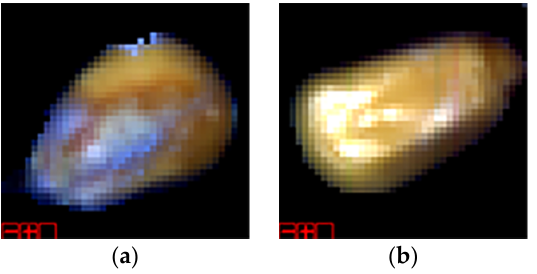
Figure 5. Pseudo ‐ color images of kernels with ( a ) symptomatic appearance and ( b ) asymptomatic appearance composited by 1095, 1291, 1543 nm.